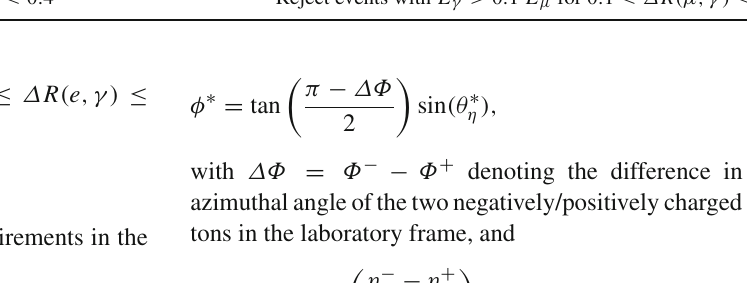
Table 2 Summary of lepton identification requirements in the calo setup Electrons Muons Combine e and γ momentum four vectors, if Δ R ( e ,γ) < 0 . 1 Reject events with E γ > 2 GeV for Δ R (μ,γ) < 0 .